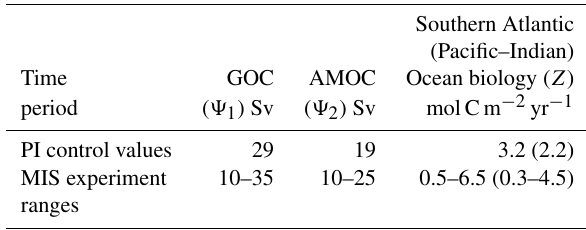
Table 1. Free-floating parameter ranges in the model–data ex- periments for global overturning circulation (GOC, (cid:57) 1 ), Atlantic meridional overturning circulation (AMOC, (cid:57) 2 ) and Southern Ocean biological export productivity ( Z ). Parameters are varied si- multaneously across these ranges and then optimized against proxy data in each MIS. Also shown are pre-industrial control values for GOC (Talley, 2013), AMOC (Talley, 2013) and Southern Ocean biological export productivity (Dunne et al., 2005; Sarmiento and Gruber, 2006; Henson et al., 2011; Siegel et al., 2014; DeVries and Weber, 2017). The Pacific–Indian Southern Ocean biology param- eter is set at a base value of ∼ 70% Atlantic Southern Ocean box but scales linearly with the Atlantic Ocean parameter in the exper- iments. The smaller values for Pacific–Indian Southern Ocean take account of natural observations of a relatively stronger biological export productivity in the Atlantic sector of the subpolar Southern Ocean (e.g. Dunne et al., 2005; Sarmiento and Gruber, 2006; Hen- son et al., 2011; Siegel et al., 2014; DeVries and Weber,